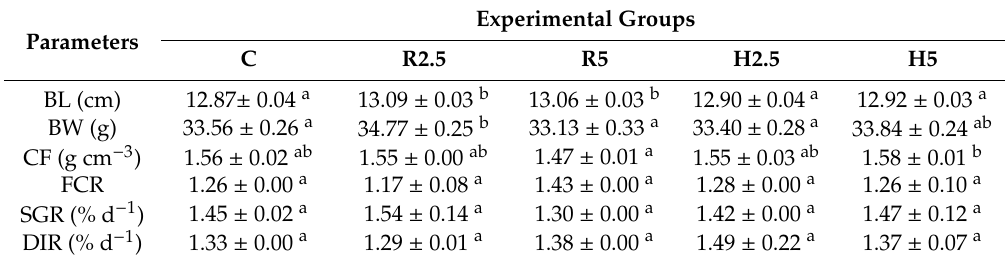
Table 3. Fish body growth parameters at day 64 of the feeding trial.